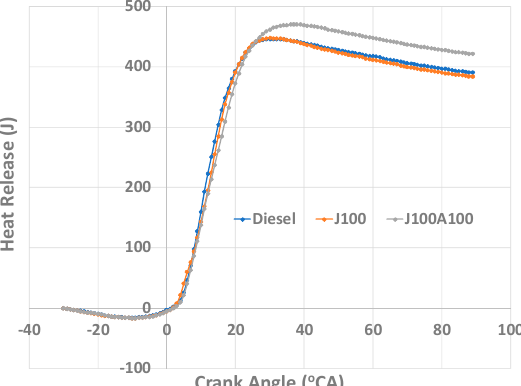
Figure 15. Total heat release at 60% load. Energies 2019 , 12 , x FOR PEER REVIEW